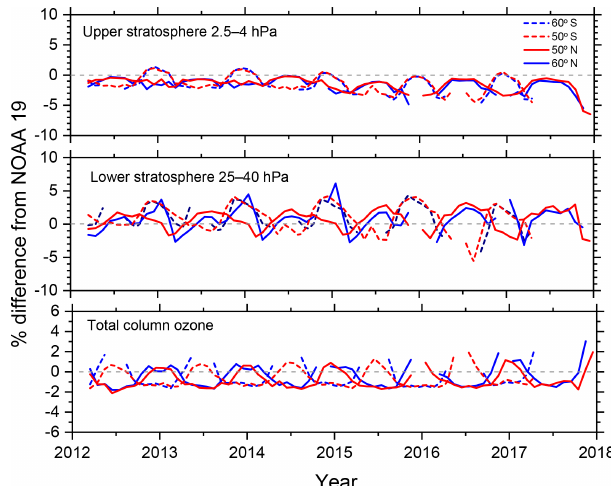
Figure 9. OMPS NP version 2 June zonal average ozone profiles (2012–2016) compared with NOAA 19 SBUV/2 profiles, MLS pro- files, and profiles from the OMPS LP. OMPS NP version 2 percent differences from N19, MLS, and LP are plotted on the right.